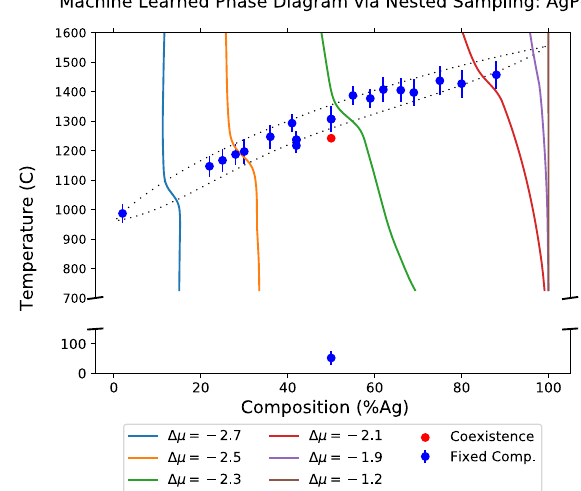
Fig. 5 Phase diagram determined by a semi-grand canonical (sGC) and fi xed-composition ensemble nested sampling (NS). Solid lines show sGC NS composition as a function of temperature for each Δ μ = μ Ag − μ Pd , with approximately horizontal jogs indicat- ing fi nite-size broadened discontinuities associated with the liquidus – solidus (L – S) gap. Dotted lines indicate experimentally observed L – S gap. Circles indicate constant composition NS speci fi c heat maxima corresponding to liquid – solid and solid – solid phase transition temperatures. We have shifted all simulation results in this fi gure up by 200 K to make it easier to compare the width of the L – S gap with the experiment. The experimental liquidus and solidus are adapted from several sources, refs. 66 – 68 . The slight difference between the NS results and coexistence results can be explained by the system size: 64 atoms for NS and 16,384 atoms for coexistence. Error bars for fi xed-composition NS are the full-width half-maximum obtained from the heat capacity